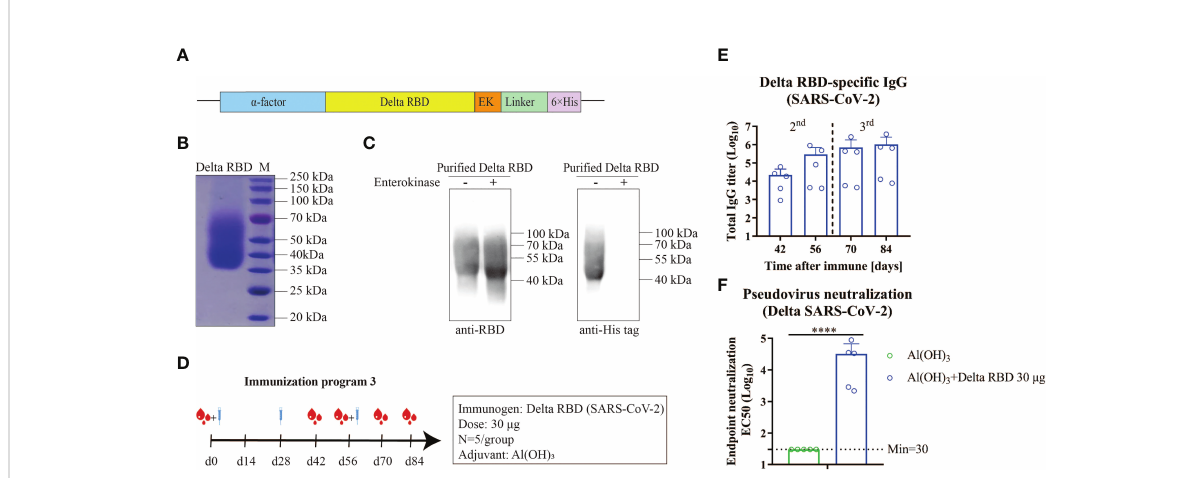
FIGURE 4 Humoral immune responses elicited by yeast-expressed Delta RBD in mice. (A) The schematic of the expression vector for Delta RBD in yeast. Delta RBD contained the a -factor signal peptide (blue) at the N terminus, and an Enterokinase (EK) site (orange) and a 6×His-tag (purple) at the C terminus. (B) The purity analysis of the puri fi ed recombinant Delta RBD stained by Commassie blue staining. (C) The identity of Delta RBD characterized by western blot analysis with the SARS-CoV-2 RBD antibody (left) and 6×His antibody (right). (D) Schematic of immunization program 3. Each mouse received 30 m g of Delta RBD protein for three times with an interval of 28-days. Serum samples were collected at the fourteen day after each immunization. (E) Measurement of the Delta RBD-speci fi c binding IgG antibodies in the serum. (F) Quanti fi cation of NAbs against the Delta variant in the endpoint (day 84) serum. Data are the mean ± SD. p -values were calculated using unpaired Student ’ s t-test. **** p <